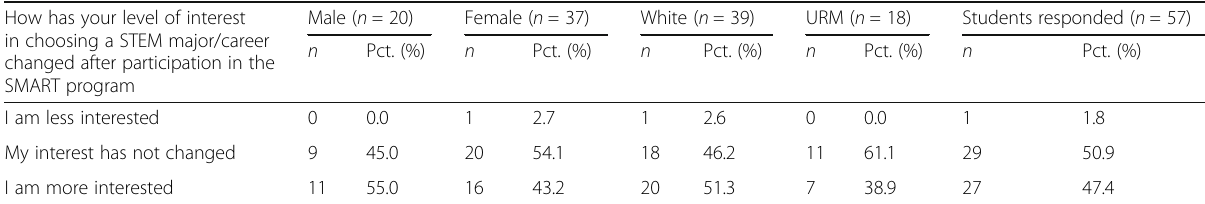
Table 5 Change in level of interest in a STEM college or career after completing SMART 2015 Cohort How has your level of interest in choosing a STEM major/career changed after participation in the SMART